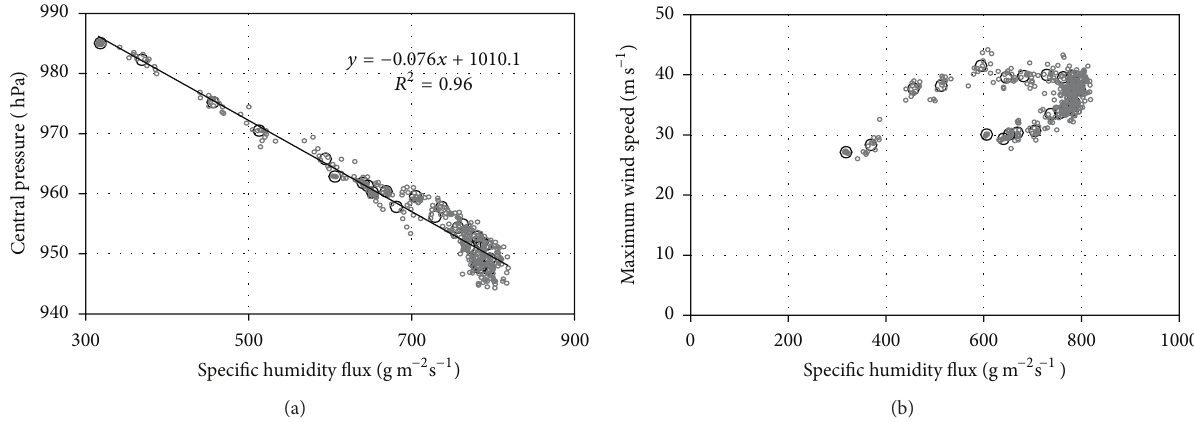
Figure 8: (a) Relationships the horizontal specific humidity flux and the simulated central pressure in the 14 experiments (gray circles) and between their averages and (b) relationships between the horizontal specific humidity flux and the simulated maximum wind speed in the 14 experiments (gray circles) and between their averages.